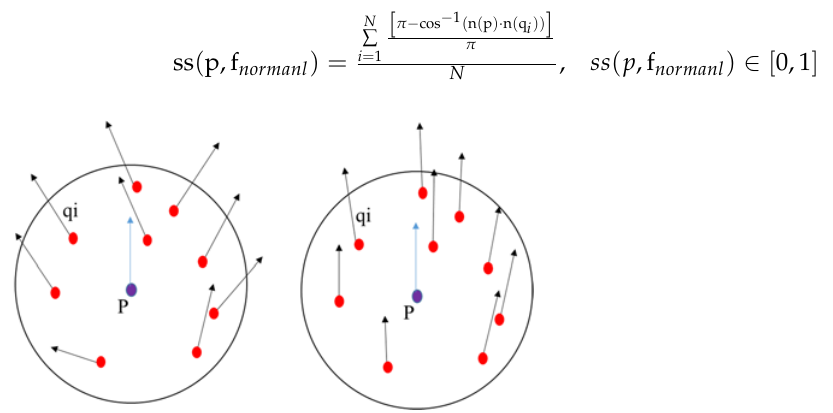
Figure 1. Showing of the normal vector similarity of the center point with other points in a spherical neighborhood.